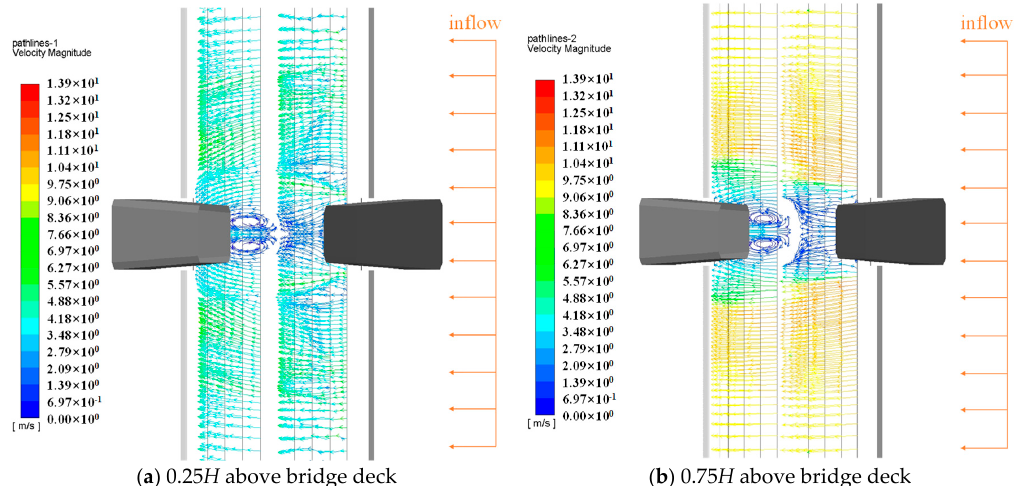
Figure 8. Flow field from numerical simulation results (C1 condition).